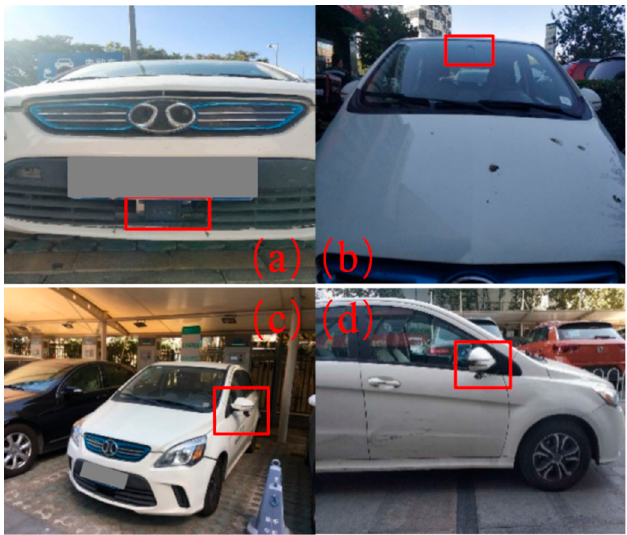
Figure 1. Data acquisition equipment mounted on the vehicle. Figure ( a ) shows the millimeter wave radar. Figures ( b ), ( c ) and ( d ) show the cameras.